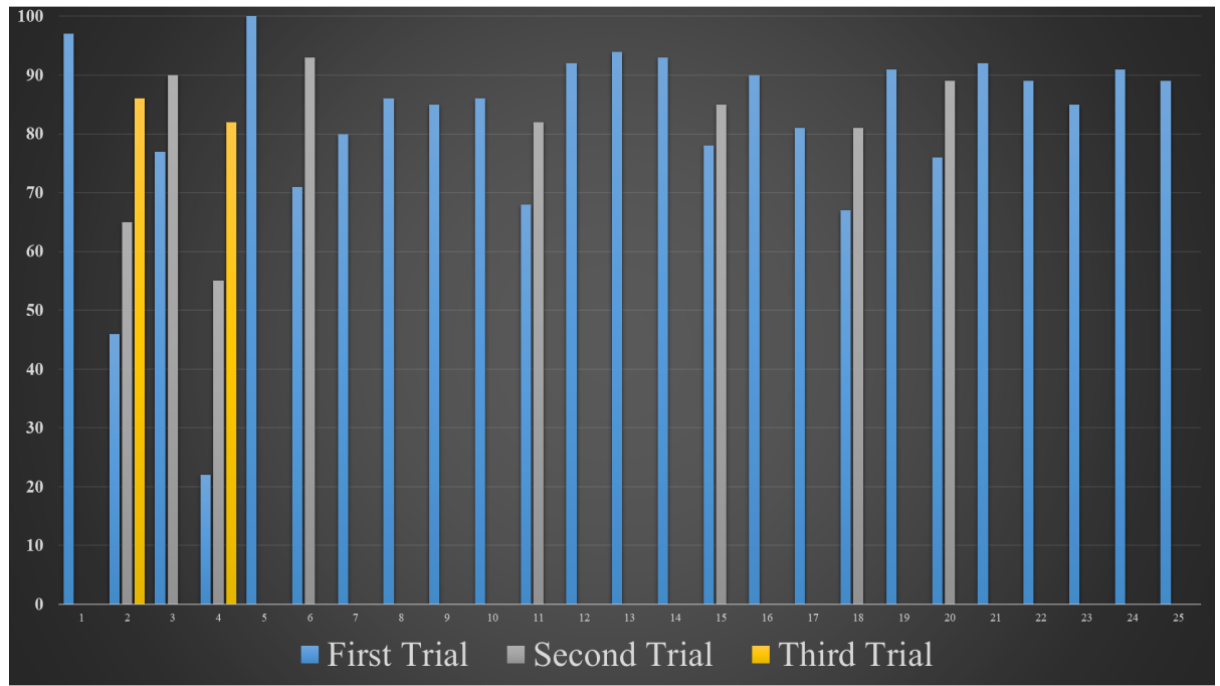
Figure 9. Serious game scores und number of trials of 25 participants.